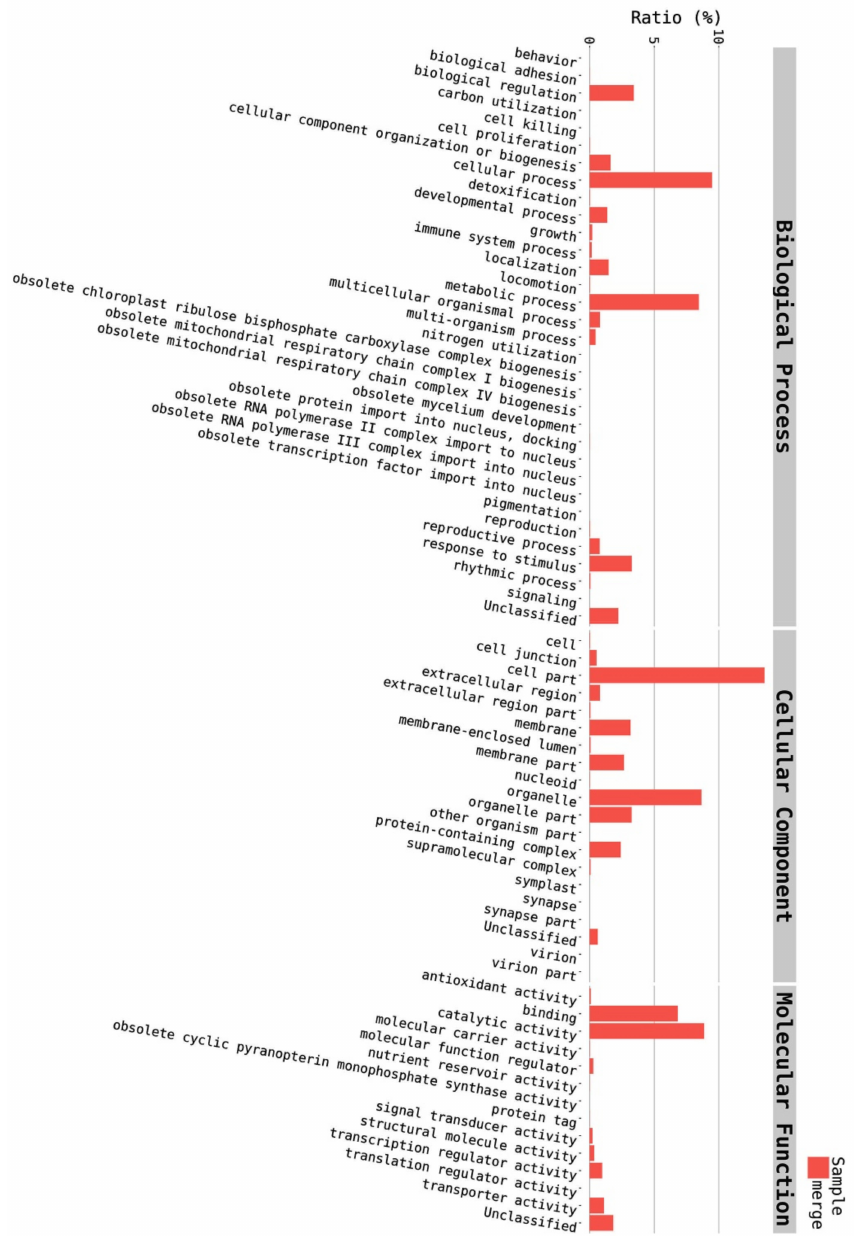
Figure 2. Distribution of annotated unigenes into the 67 functional groups of biological process (BP), cellular component (CC), and molecular function